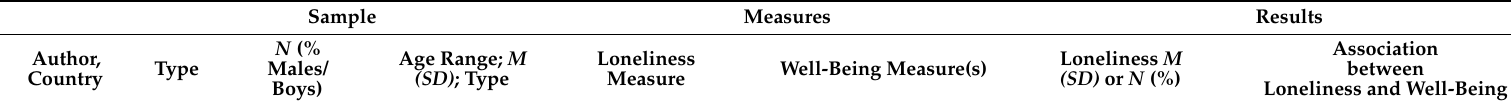
Table 2. Summary of Longitudinal